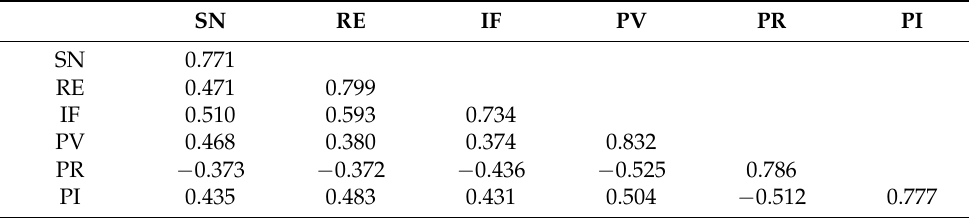
Table 4. Matrix of square root of factor AVE values and inter-factor correlation coefficients.